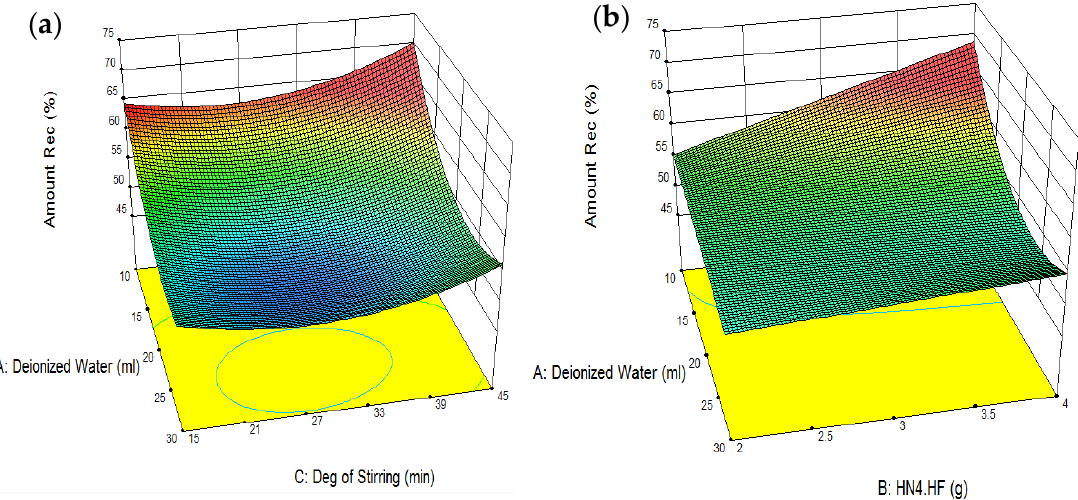
Figure 7. 3D plots of REF recovery with respect to process variables at ( a ) 4 g of NH 4 F · HF and ( b ) 43 min for degree of stirring.